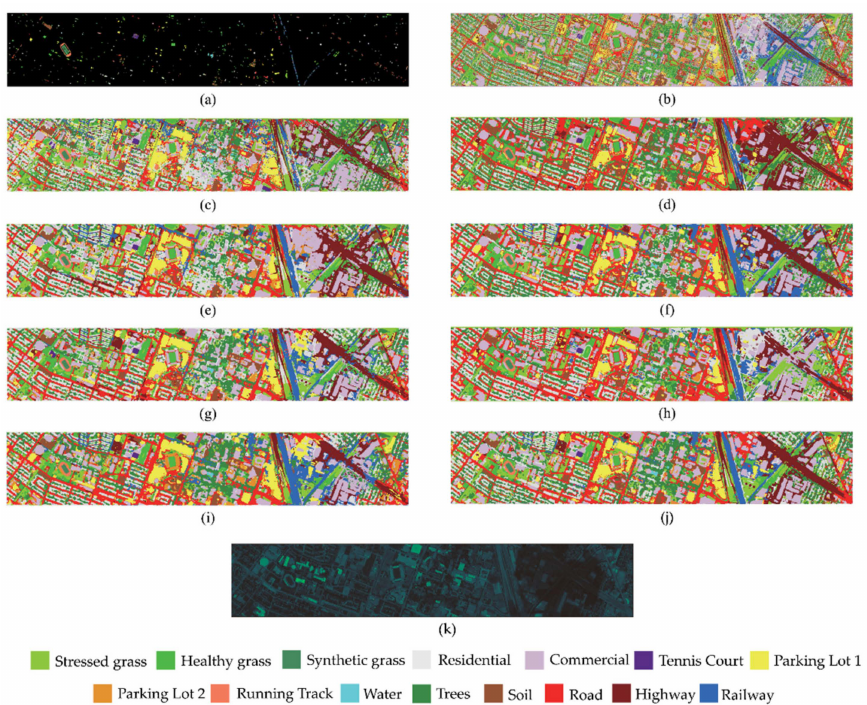
Figure 10. Full-factor classification maps for the HS dataset. ( a ) Ground-truth. ( b ) SVM. ( c ) HYSN.